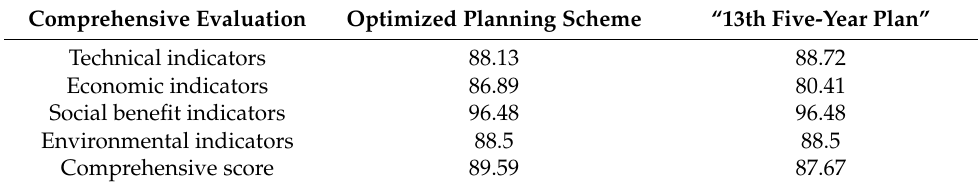
Table 9. Comparison of the two planning